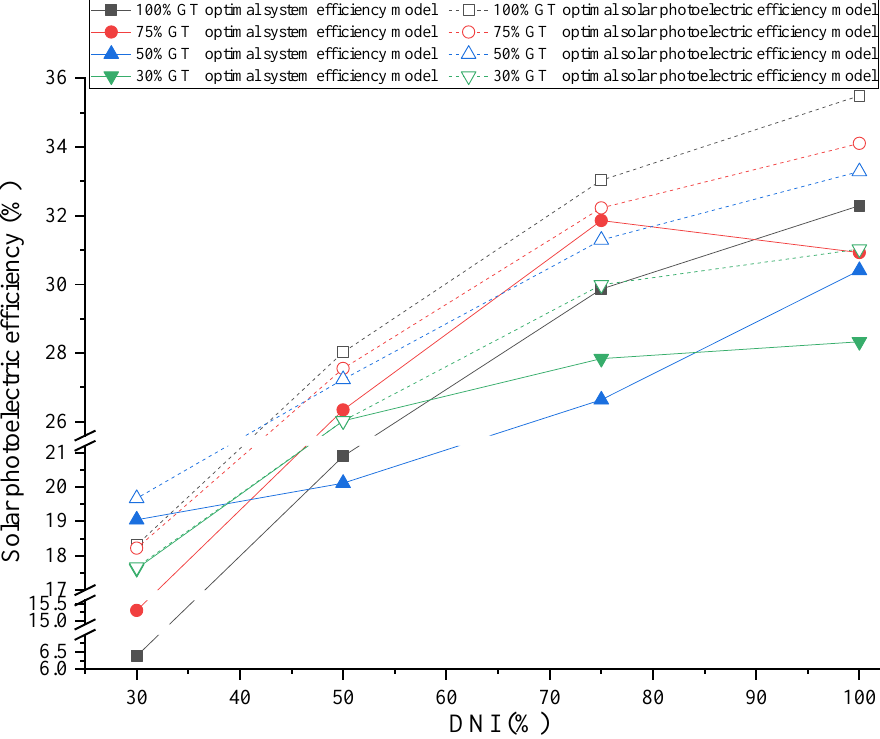
Figure 9. Trend of ISCC solar photoelectric efficiency with fluctuation of DNI.